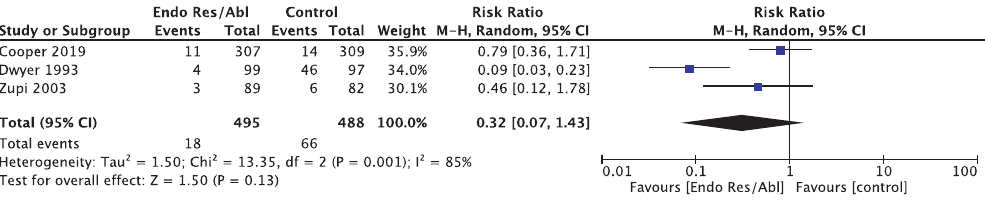
Figure 5. Forest plot for postsurgical complications rates.